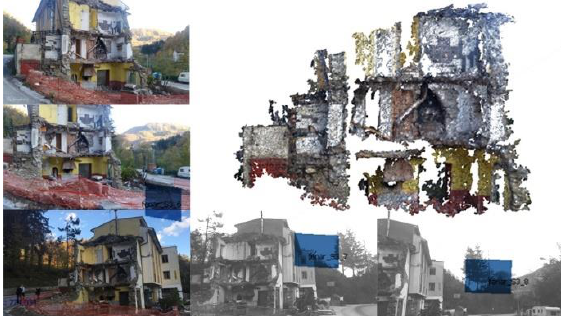
Figure 7. 3D point cloud of some ruins, SMAC data,